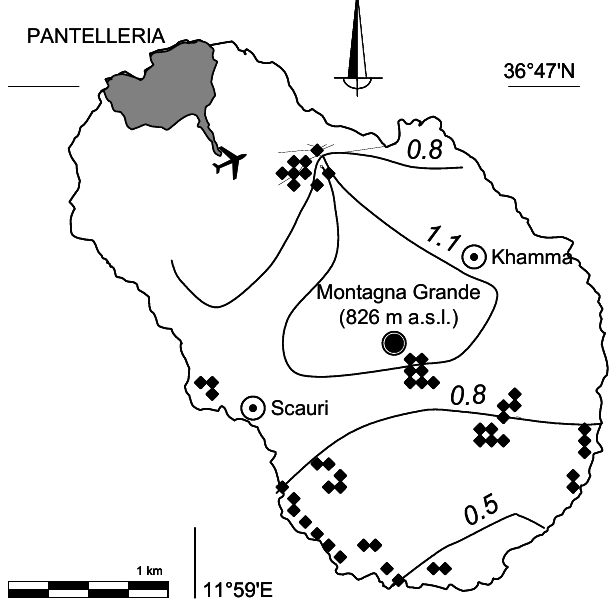
Figure 1. Sites where soils were sampled for this study, where lines indicate the percent of soil total carbon at depth of 30 cm. The grid is irregular as sampling was carried out for extracting the highest C variability, regionalized by the use of soils. In particular, northern sampling points collected the greater variability of soils in terms of crops. In the South, the variability is given by the natural environment of the Mediterranean vegetation, while towards West by different gradients of human pressure. A regular sampling grid would not have correctly interpreted this intrinsic variability.